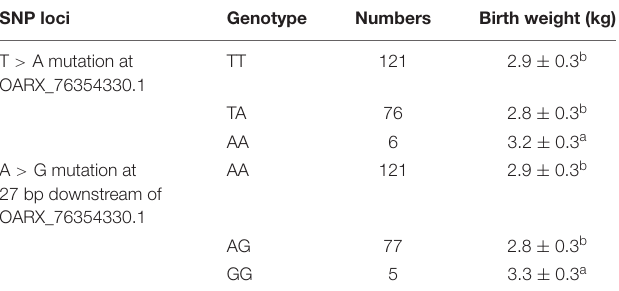
TABLE 2 | Association analysis between SNPs and birth weight of Hu sheep.